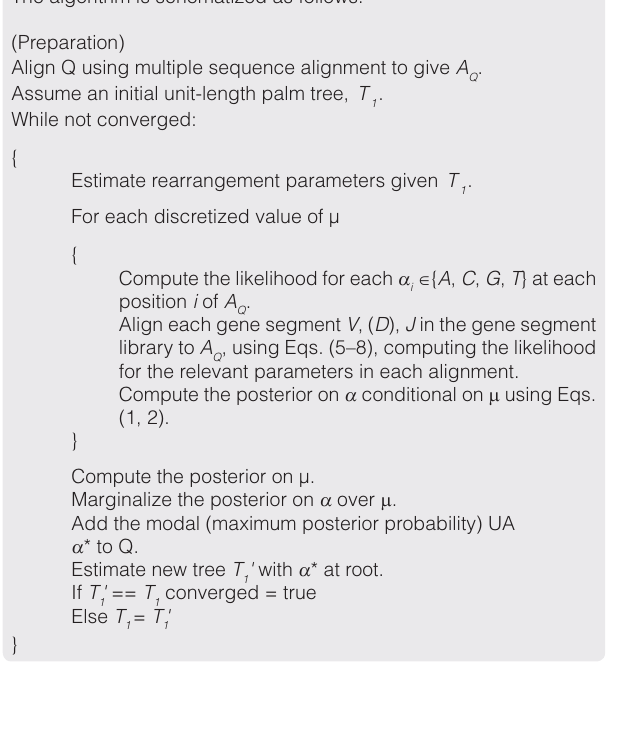
Figure 2. Phylogram of Clone H. The scale bar shows evolutionary distance, or expected number of mutations per position.